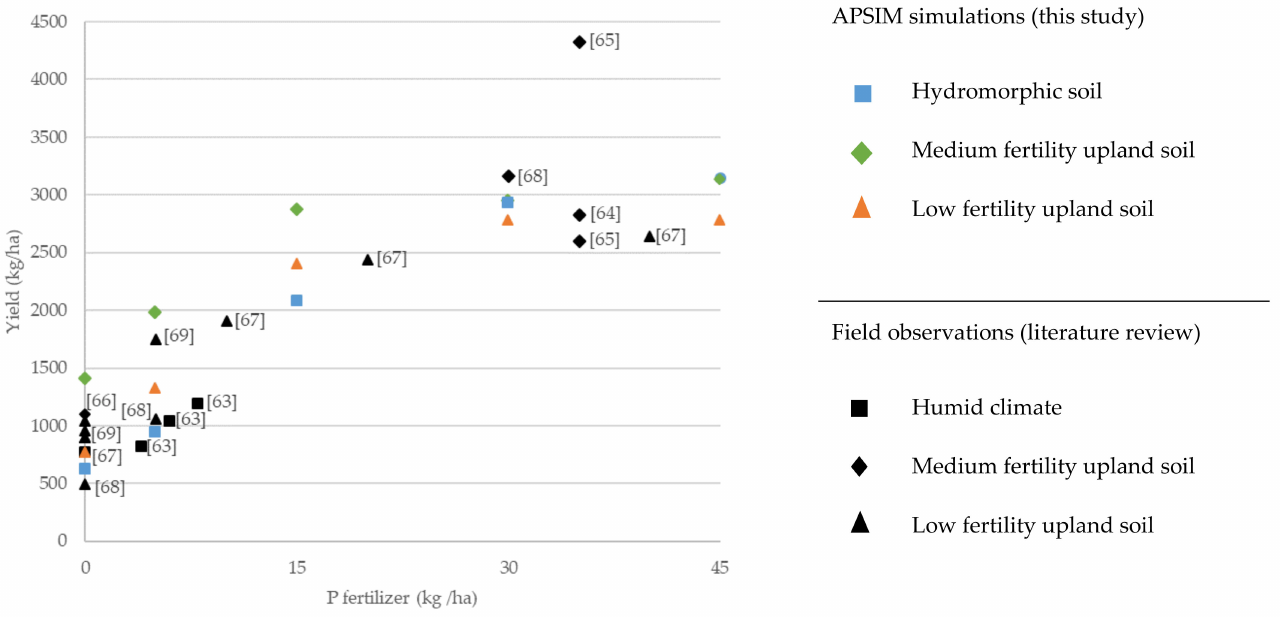
Figure 2. Millet simulated vs. published observed grain yields per fertilizer input level and soil fertility class. Numbers within brackets [] ([55–62]) indicate the reference of the publication from which data was retrieved.